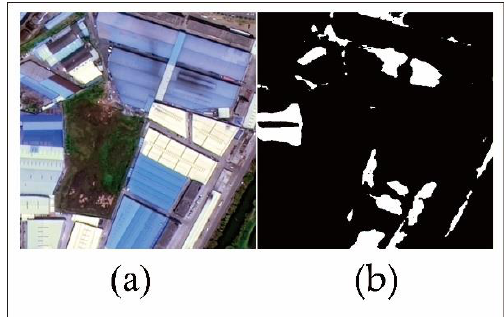
Figure 13. The extraction results and the actual distribution of blue steel roofs in the tenth area: ( a ) is the GF-2 image, and ( b ) is the extraction results.